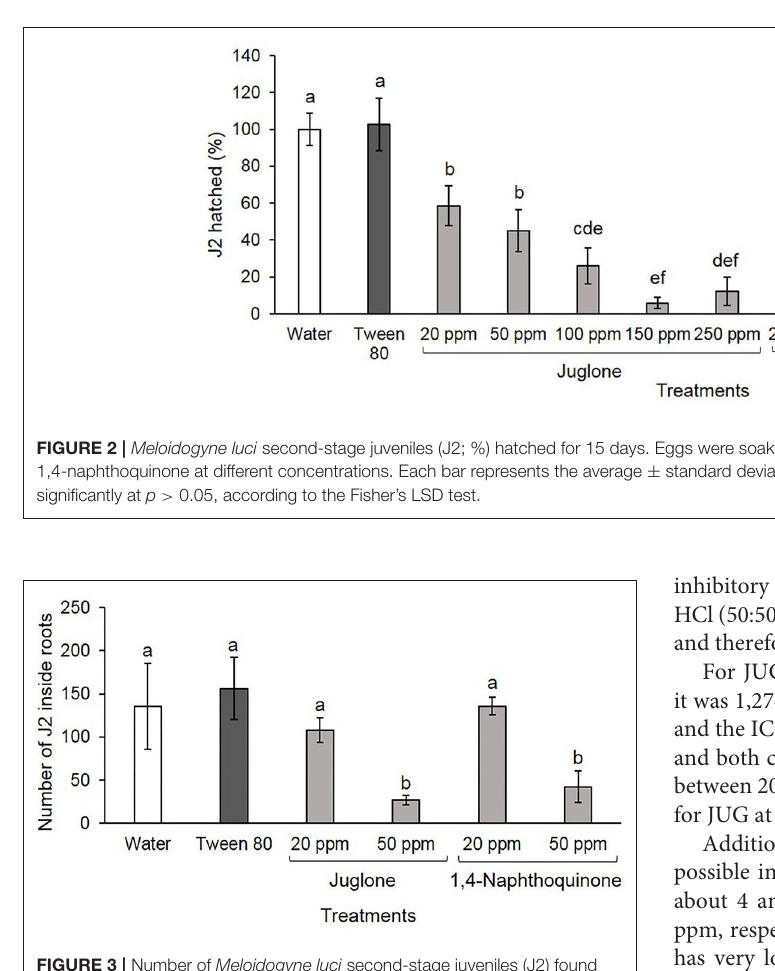
FIGURE 3 | Number of Meloidogyne luci second-stage juveniles (J2) found inside tomato cv. Coração-de-Boi roots, 3 days after inoculation. Before inoculation, J2 were soaked for 3 days in water, 2,500 ppm Tween ® 80 solution, and juglone and 1,4-naphthoquinone at 20 and 50 ppm. Each bar represents the average ± standard deviation of four replicates and bars denoted by different letters differ significantly at p > 0.05, according to the Fisher’s LSD